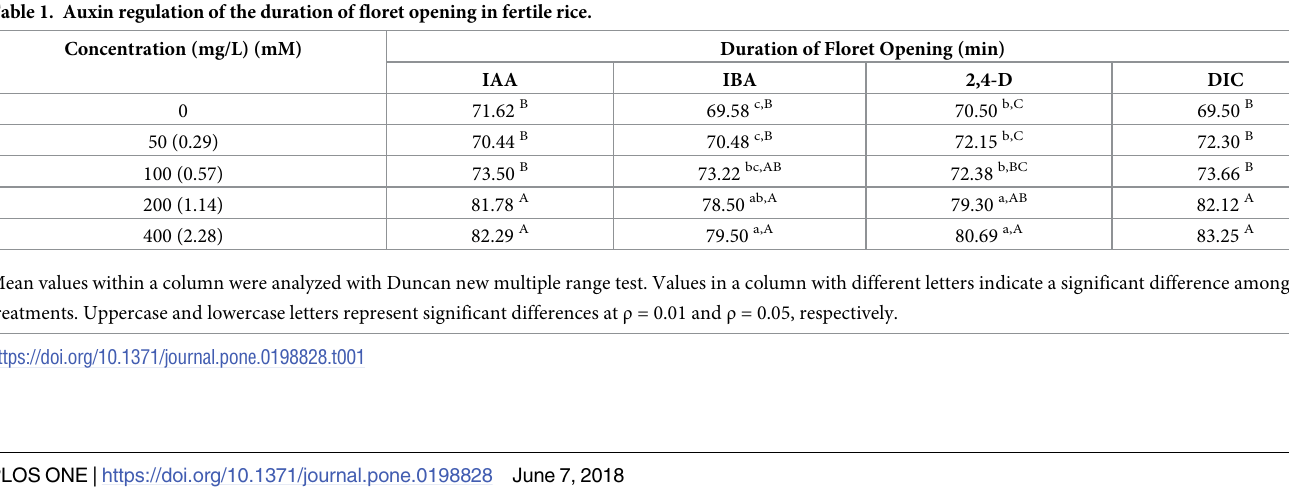
Table 1. Auxin regulation of the duration of floret opening in fertile rice. Concentration (mg/L) (mM)